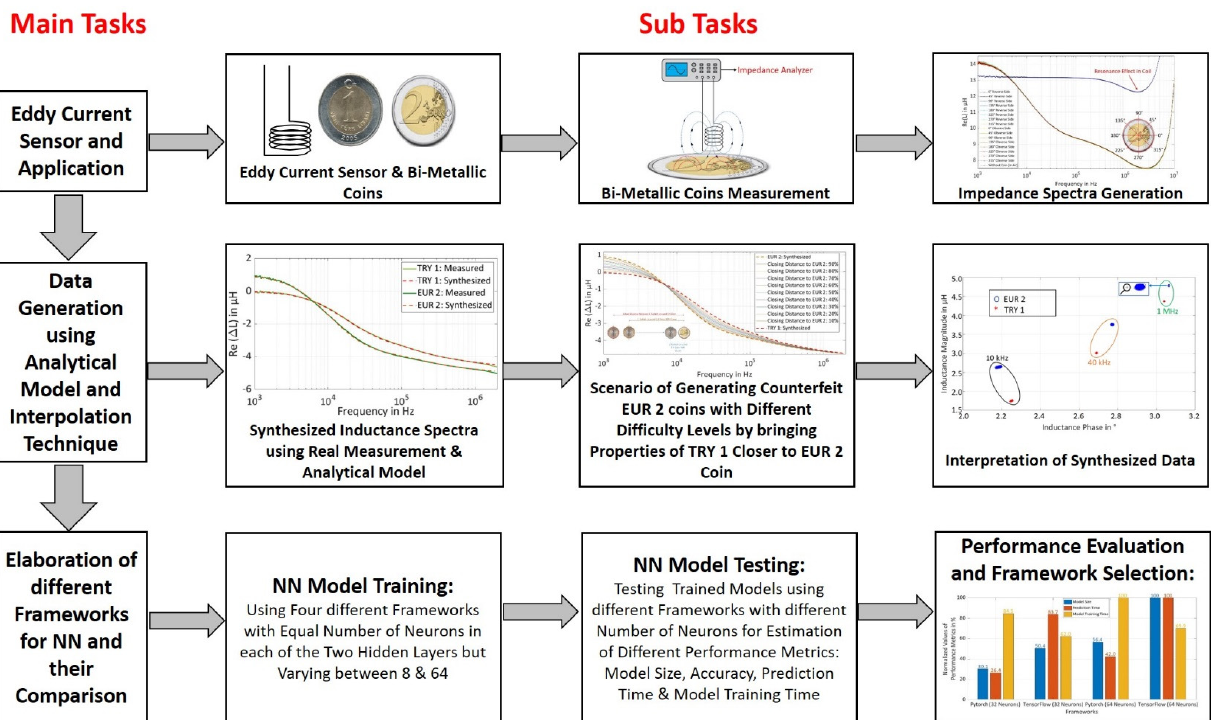
Figure 1. Methodology of Investigations for Four Frameworks ‘Keras with TensorFlow, Pytorch, TensorFlow, and CNTK’.